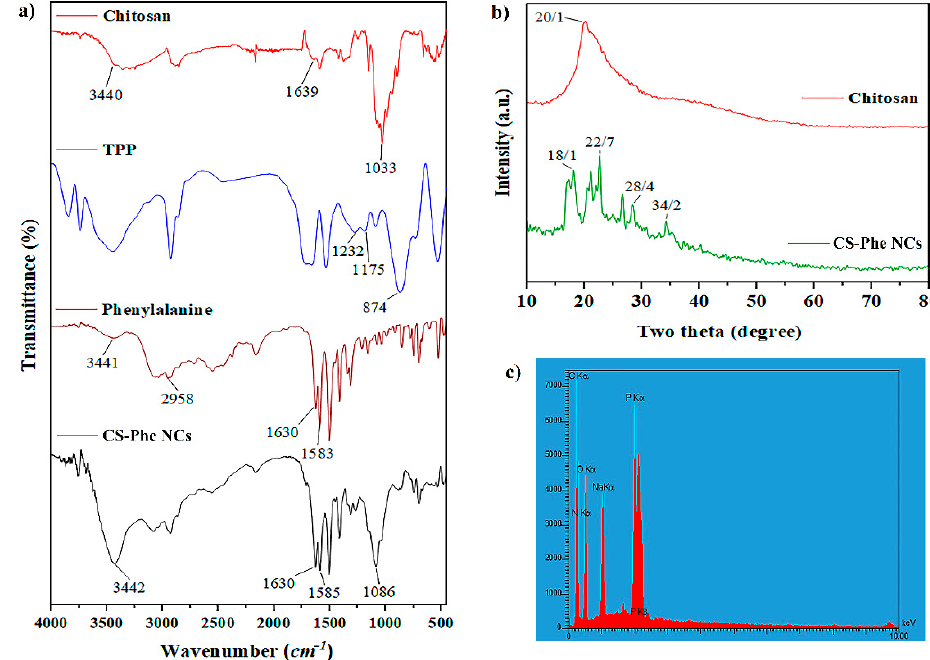
Figure 1. FT-IR ( a ), XRD ( b ), and EDS ( c ) analyses of raw materials and chitosan–phenylalanine nanocomposites (CS–Phe NCs).